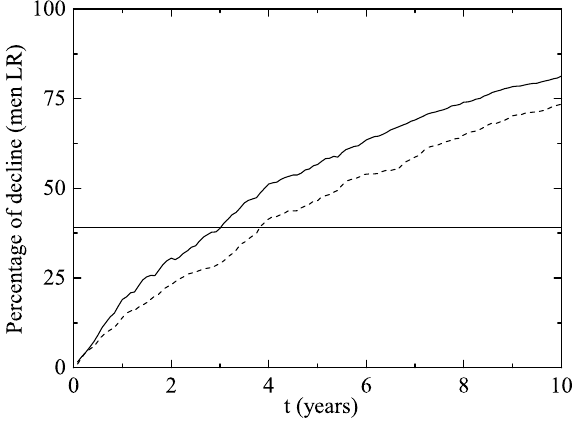
Figure 4. The same as Figure 3 but for men aged 14–26.